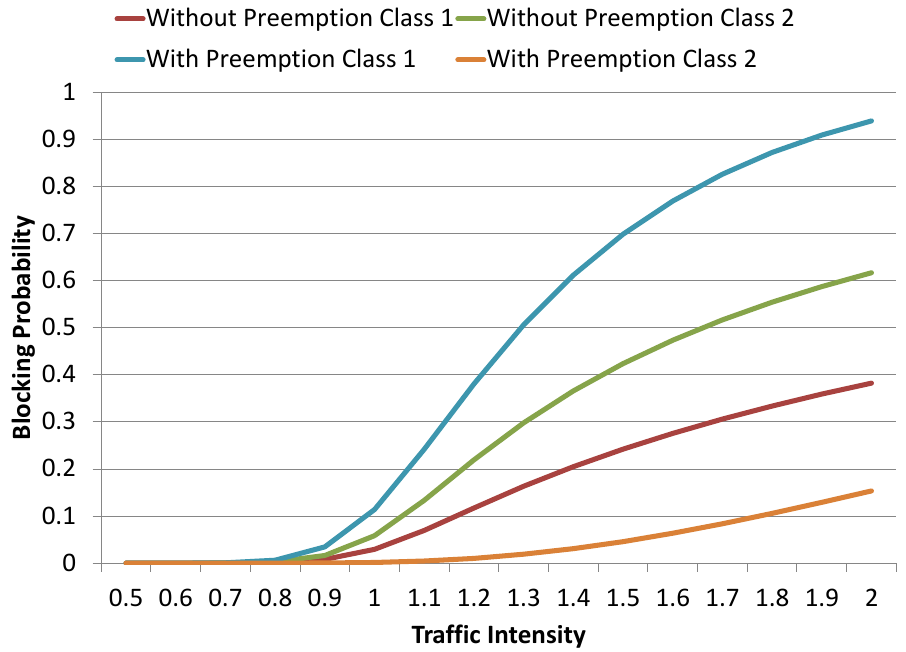
Figure 12. Class-wise comparative analysis of blocking probabilities for preemptive and non- preemptive Model results with C = 30